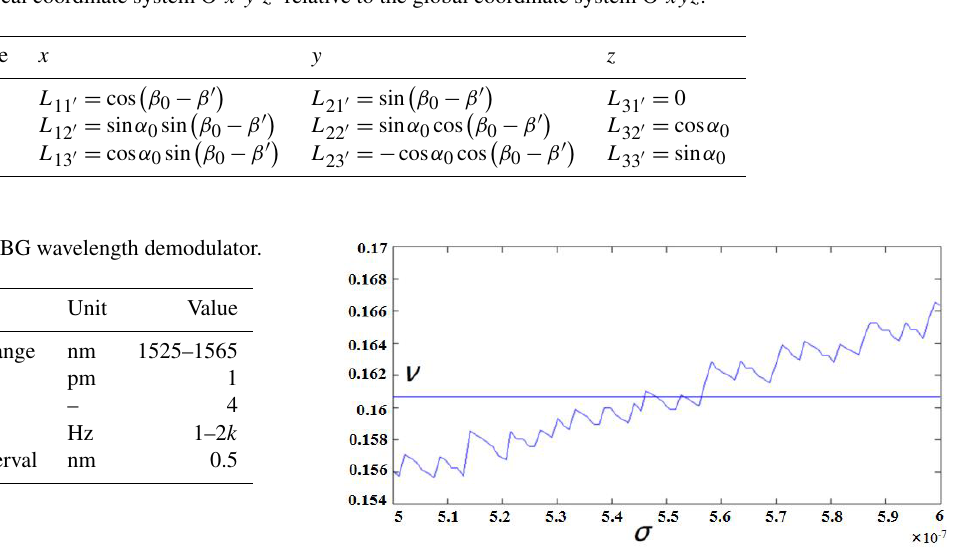
Figure 11. Calculation curve of Poisson’s ratio.